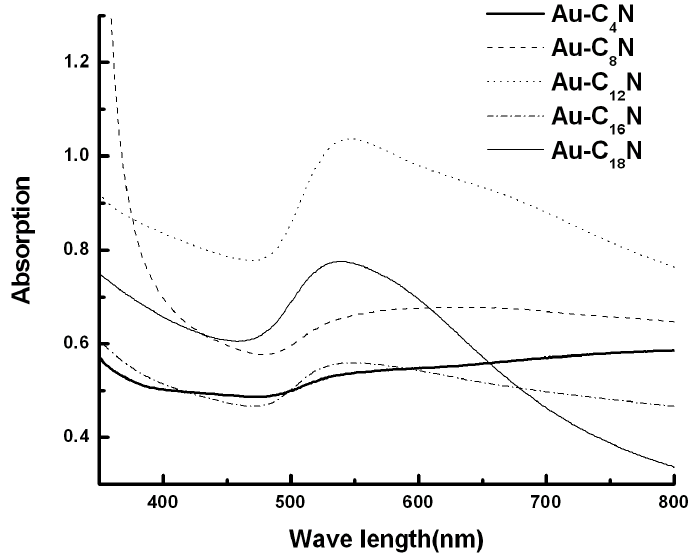
Figure 15. Comparison of surface plasmon resonance of these gold-amine colloids after digestive ripening in